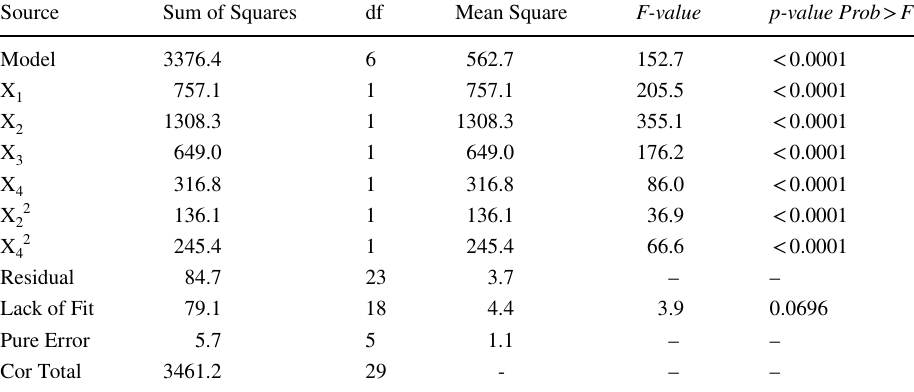
Table 3 Analysis of variance (ANOVA) of the proposed model for the developed treatment